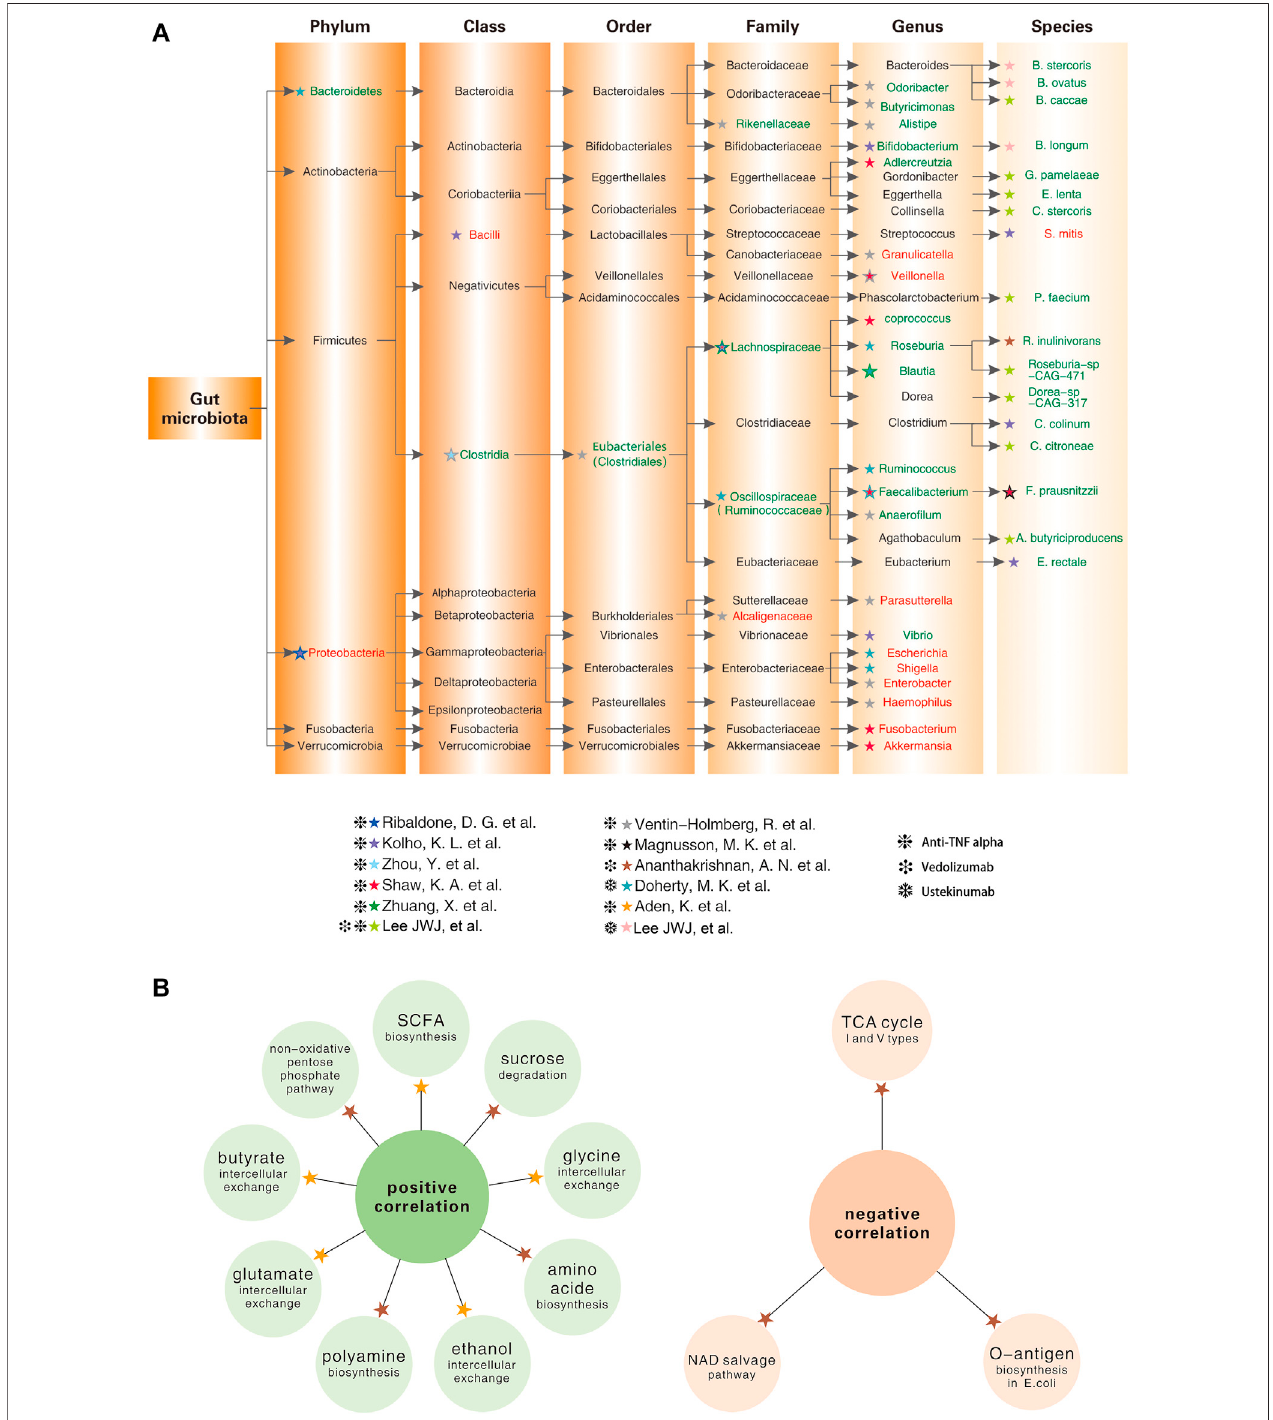
FIGURE 1 | Baseline levels of gut microbial taxa and intestinal metabolism in IBD patients associate with different responses to biologic agents (Kolho et al., 2015; Magnussonet al.,2016;Shaw et al.,2016;Ananthakrishnanet al.,2017;Dohertyet al.,2018;Zhouet al.,2018; Adenet al.,2019;Ribaldone et al.,2019;Zhuanget al., 2020; Lee et al., 2021; Ventin-Holmberg et al., 2021). (A) Lineage diagram showing the baseline abundance of speci fi c gut microbes positively (in green font) or negatively (in red font) correlated with the good response to biologic agents; (B) The left panel shows intestinal metabolites that are positively correlated with the good response to the biologic agents; the right panel shows intestinal metabolites that are negatively correlated with the good response to the biologic agents.